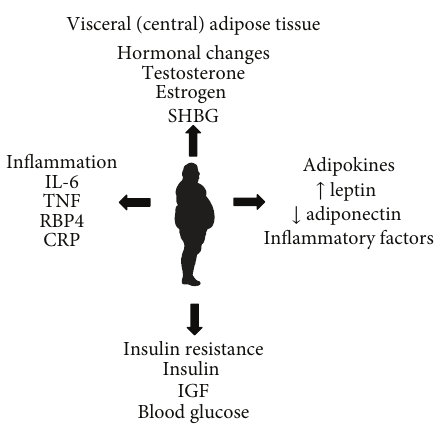
Figure 1: Central obesity leads to the secretion of multiple inflam- matory mediators that can worsen prostate cancer-specific out-